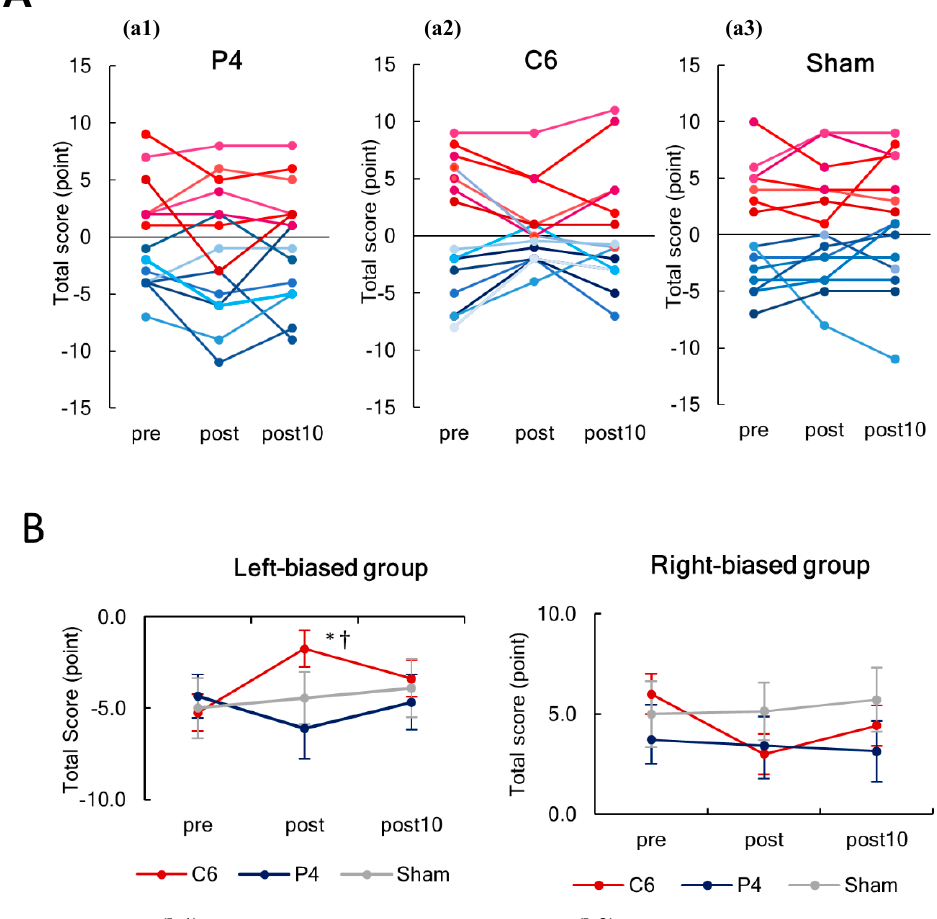
Figure A1. These figures show results without an outlier from the left-biased group. ( A ) Serial changes in the individual total scores of line length judgement task before (pre), immediately after (post), and 10 min (post 10) after tSMS for 20 min. Scatter plots present the individual values for each stimulation condition: ( a1 ) P4, ( a2 ) C6 and ( a3 ) sham stimulation. Nine subjects showed a rightward bias (reddish lines), and seven subjects showed a leftward bias (blue lines). ( B ) Serial changes in the total scores of line length judgement task before (pre), immediately after (post), and 10 min (post 10) after tSMS for 20 min, separately presented for the left-biased group ( b1 ) and right-biased group ( b2 ). In the left-biased group, the magnitude of bias was significantly reduced immediately after tSMS over C6, and the bias was significantly smaller for C6 as compared to P4 at post. * p < 0.001 vs. pre, † p < 0.05 vs. tSMS over P4.